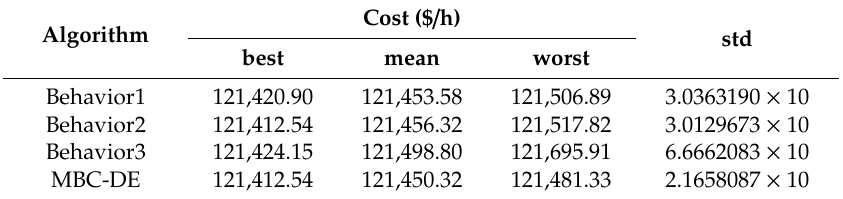
Table 12. Algorithm comparison between multi-behavior and single-behavior for test case 3.